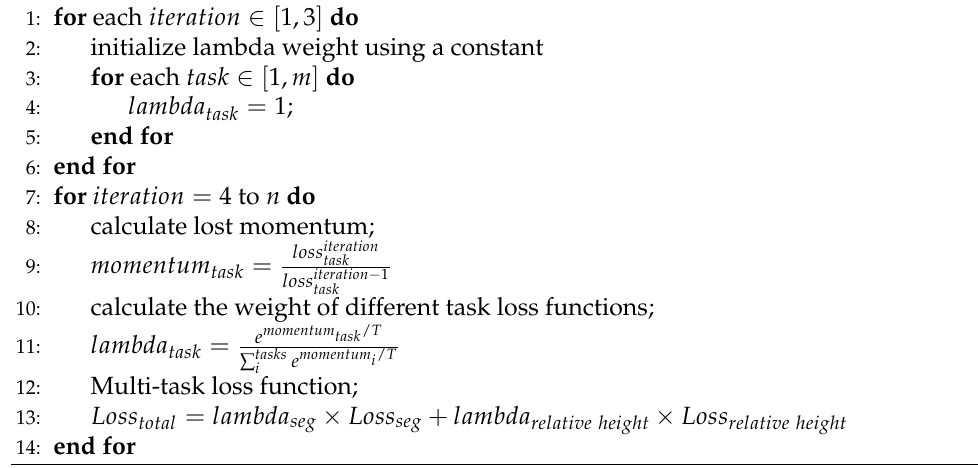
Algorithm 1 Weight dynamic adjustment algorithm for Multi-task training loss